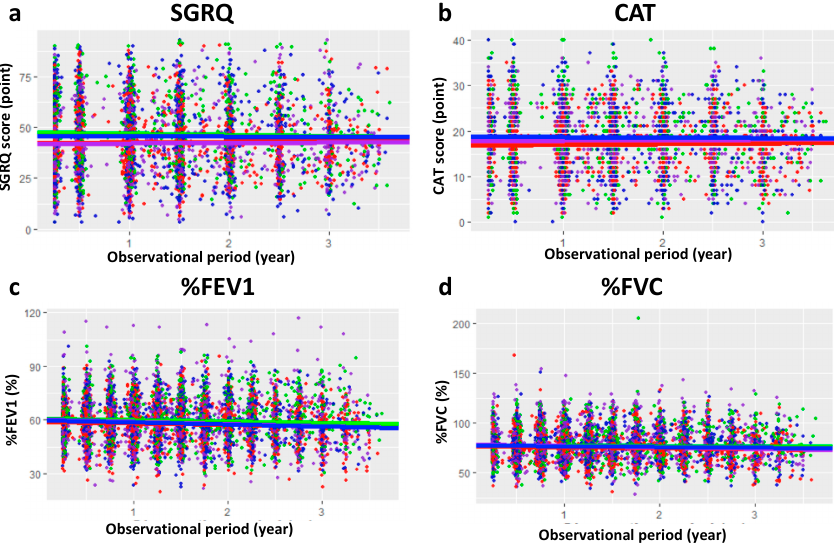
Figure 1. Changes of biomarkers within the observational period of SUMMIT trial. Observed data from SGRQ score ( a ), CAT score ( b ), %FEV1 ( c ), and %FVC ( d ) were plotted versus the original trial period. The evolutions of each sub-group’s biomarker estimated by using LMEM analysis were drawn. Blue: current smoker with previous exacerbation, Purple: current smoker without previous exacerbation, Green: ex-smoker with previous exacerbation, Red: ex-smoker without